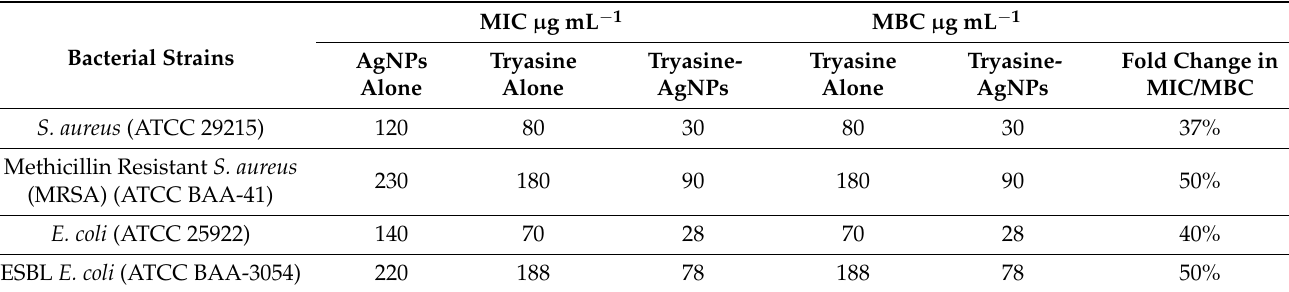
Table 2. MIC and MBC of Tryasine and Tryasine-AgNPs conjugate on standard and resistant bac- terial strains.